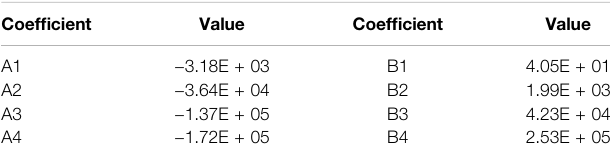
TABLE 5 | Coef fi cient values for f σ x ( x ) .